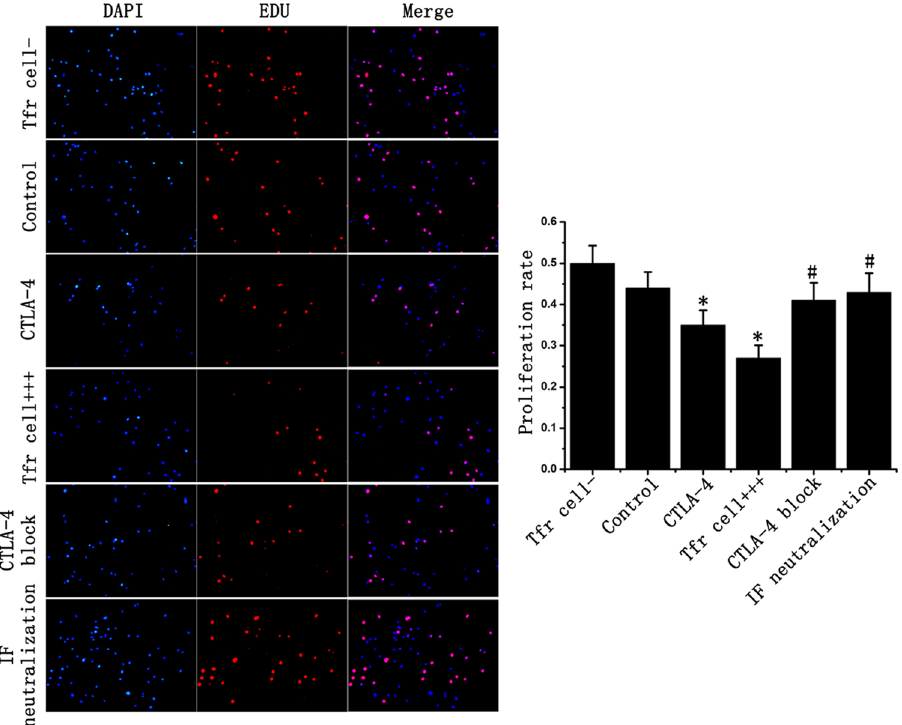
Figure 5. Tfr cells inhibit B cell proliferation in renal transplantation. After mixed lymphocyte culture, B cells were sorted and cultured for 48 hours. All B cells were stained with DAPI (blue) and proliferating cells were stained with EDU (Red). The results showed B cell proliferation rate in Tfr cells +++ and CTLA-4 group was significantly lower than that in the control group. CTLA-4 block or inhibitory factor could partly weakened this inhibitory effect of Tfr cell. Student’s t test: * p < 0.05 (n = 3) versus Control; # p < 0.05 (n = 3) versus Tfr cells +++ . Values are mean ±